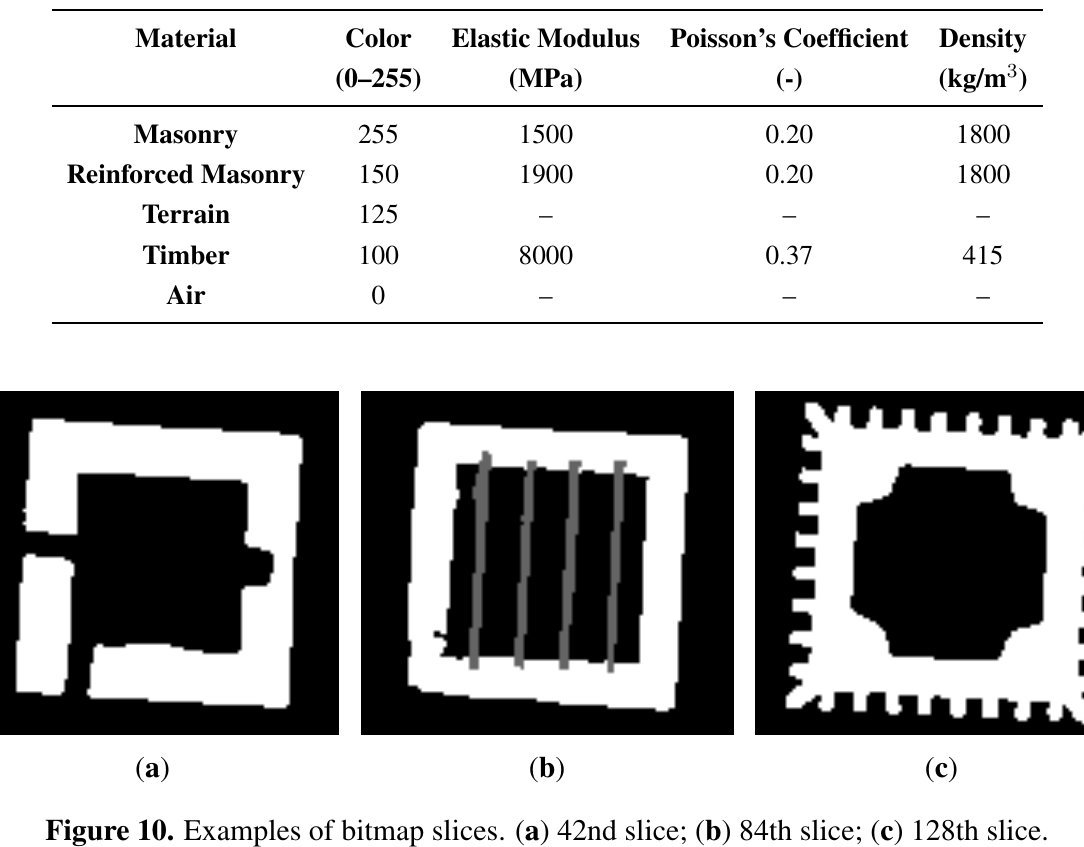
Table 1. Mechanical characterization of the materials by color.